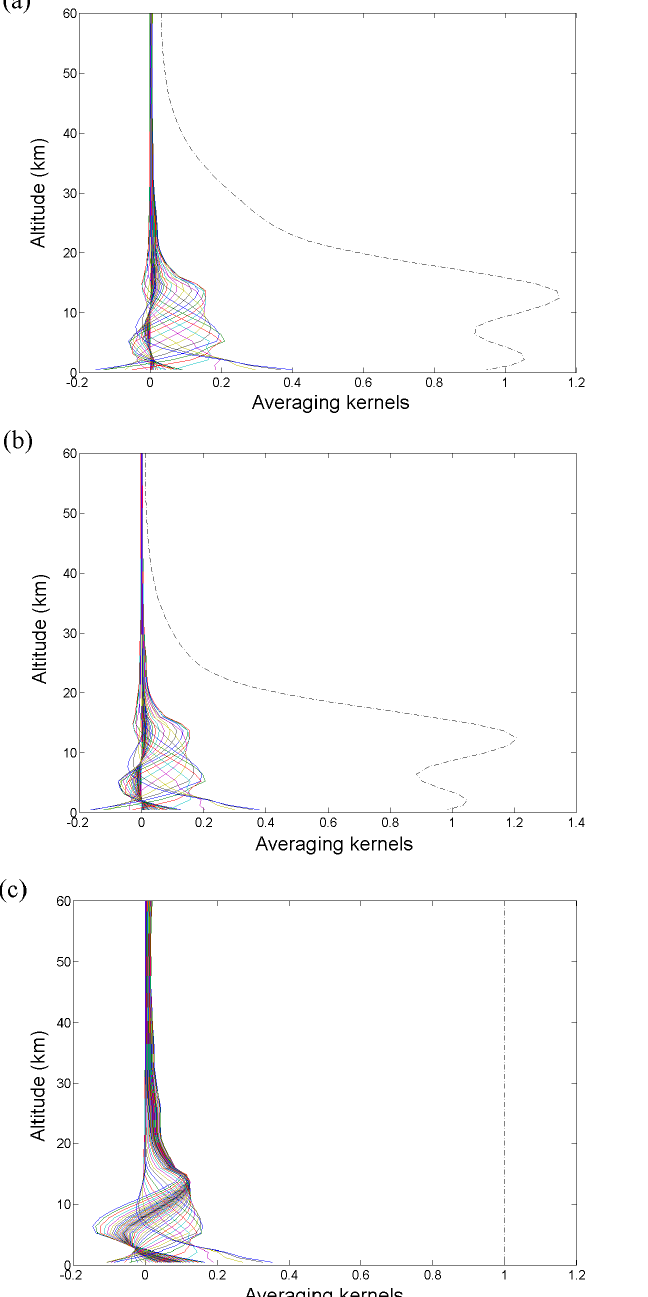
Figure 10. Averaging kernels and sensitivity curve (black dashed) for the CO retrieval from a single spectrum on 29 July 2007 at St.-Denis using the (a) OEM, (b) IOA and (c) TR.